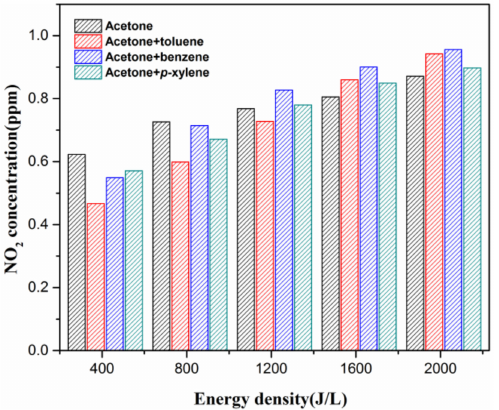
Figure 5. EffectsofenergydensityonNO 2 production. Reactionconditions: acetone: 250ppm, BTEX:50ppm, RH: 50%, and total flow 2